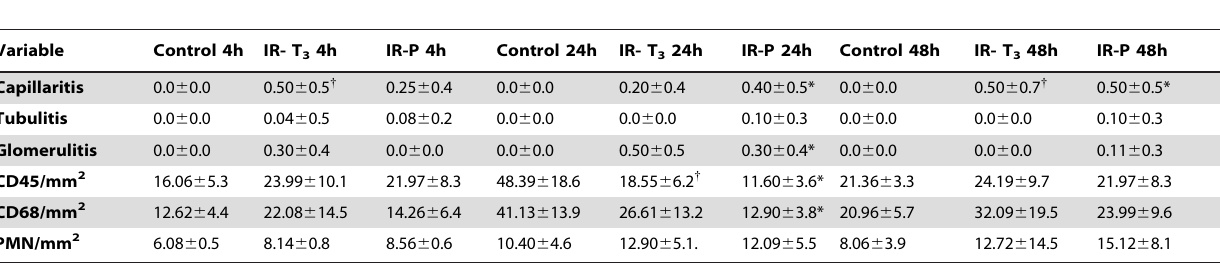
Table 2. Assessment of kidney biopsies and quantification of inflammatory infiltrate in rat control and ischemia/reperfusion groups at different